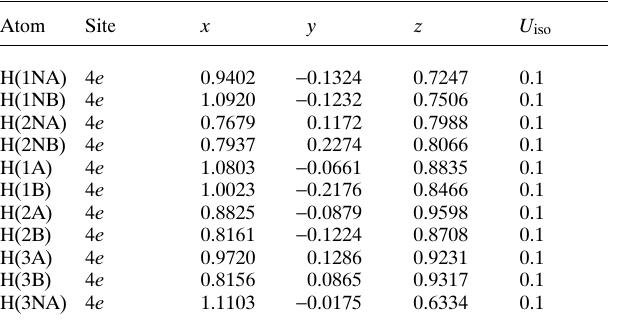
Table 2. Atomic coordinates and displacement parameters (in Å 2 )